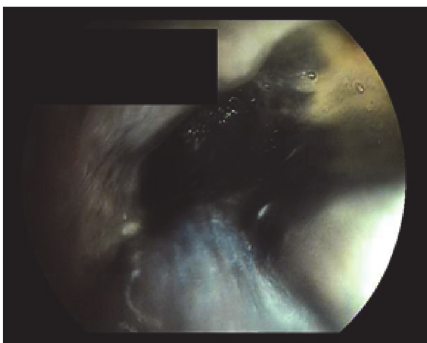
Figure 1: Endoscopic image of proximal esophagus showing cir- cumferentially black mucosa.